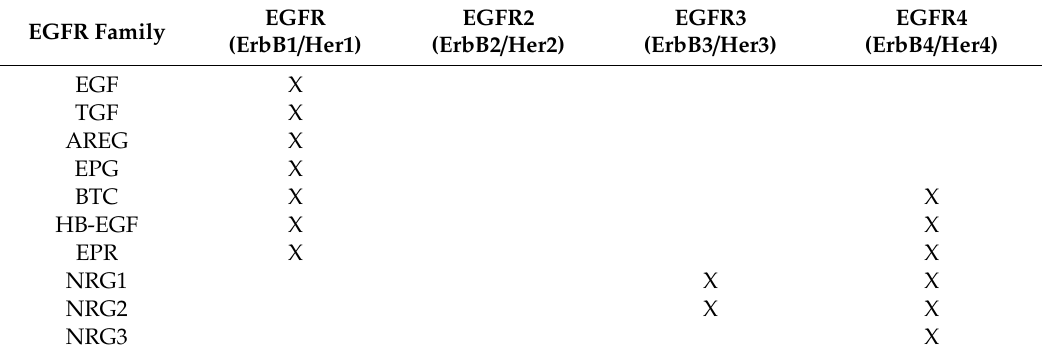
Table 1. The EGFR family members and their interacting ligands. Adapted from Hynes and Watson [34]. EGFR EGFR2 EGFR3 EGFR Family (ErbB1 / Her1) (ErbB2 / Her2) (ErbB3 /